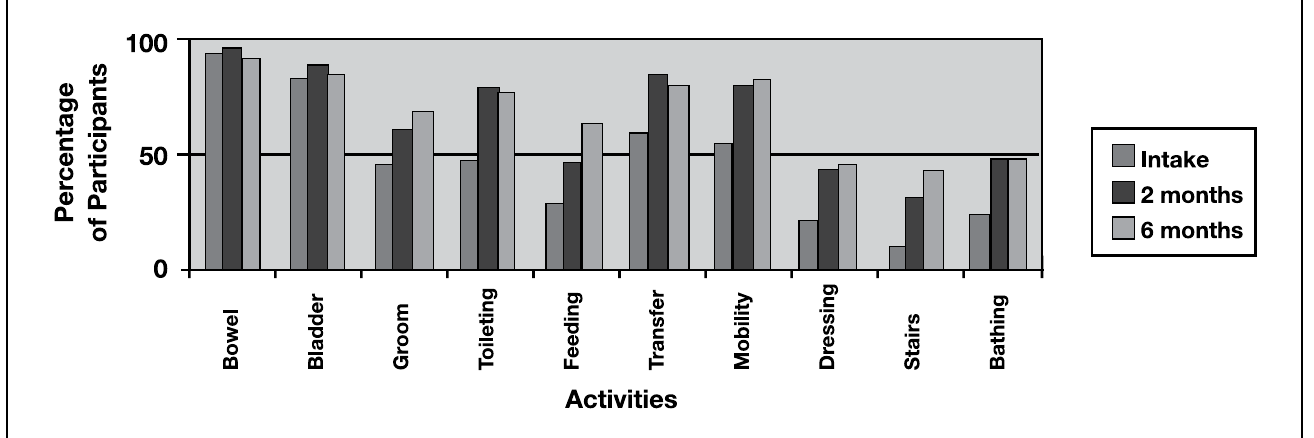
Figure 2: Percentage of participants who were independent on the 10 sub-items of the Barthel index at baseline (n=100), two (n=88) and six months (n=76) post stroke